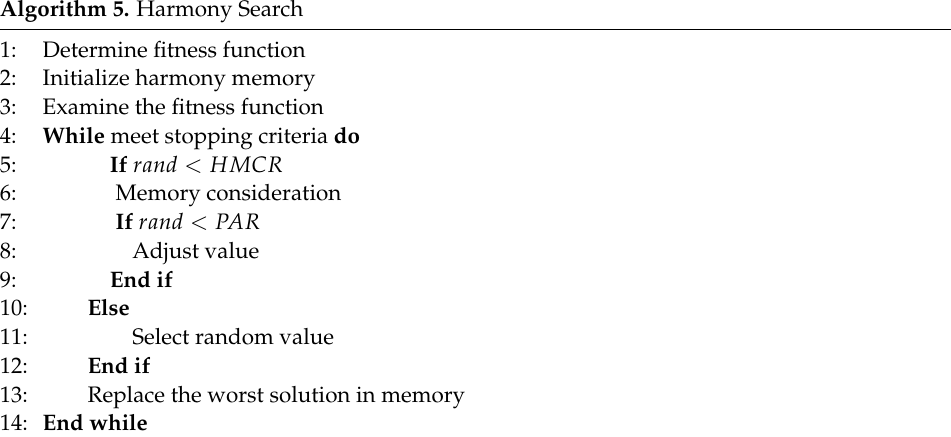
Algorithm 5. Harmony Search